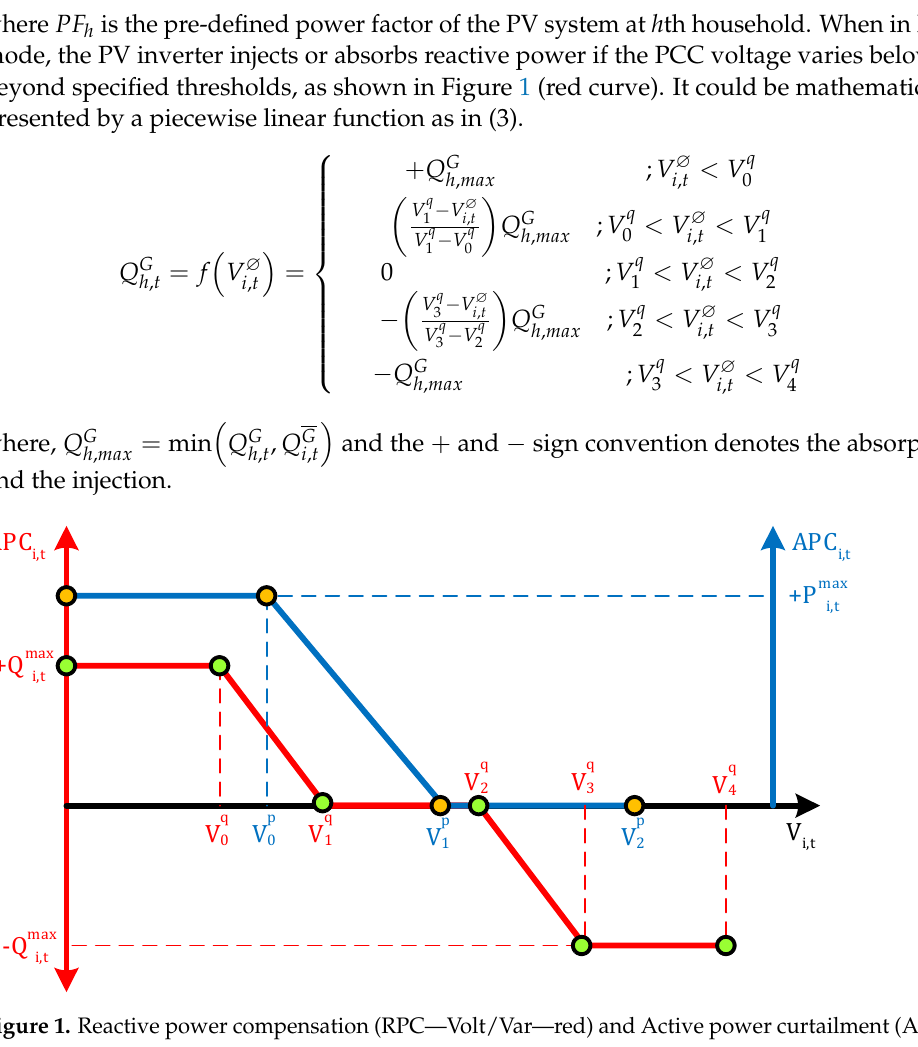
Figure 1. Reactive power compensation (RPC—Volt/Var—red) and Active power curtailment (APC—Volt/Watt—blue) schemes.